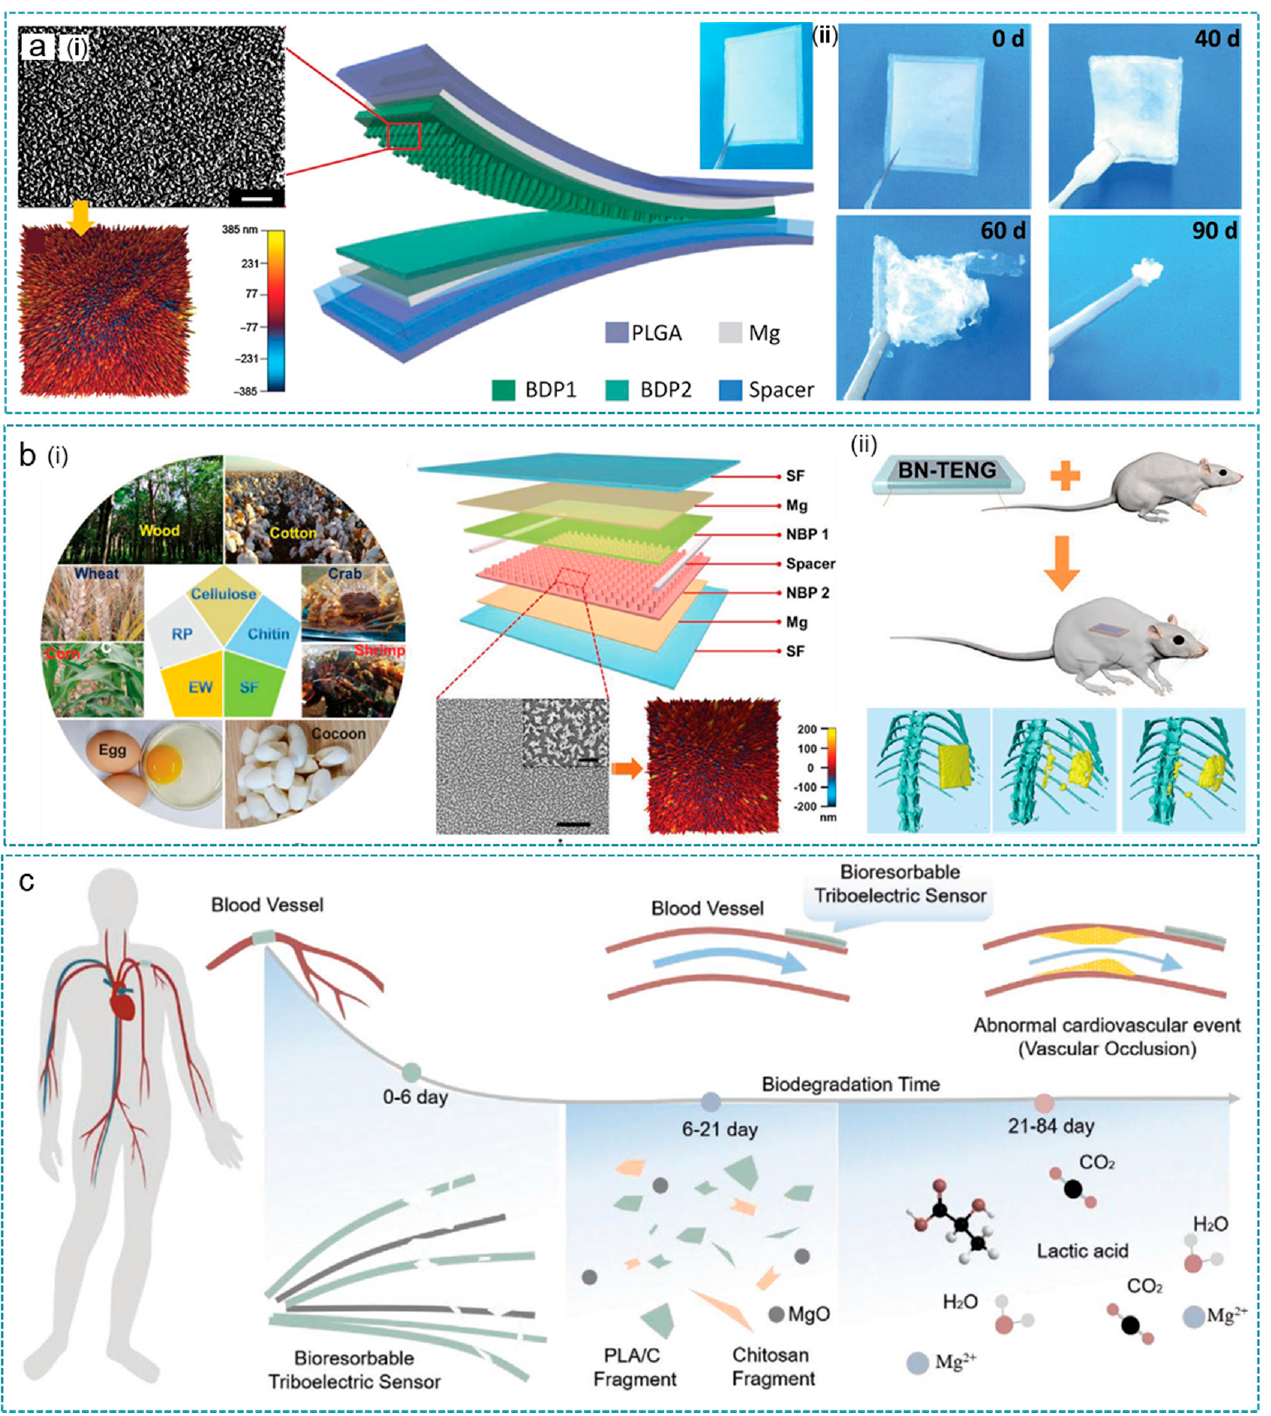
Figure 9. Degradable and absorbable TENGs. ( a ) Biodegradable TENG (BD-TENG) as a lifetime designed implantable power source. The structure diagram (i) and in vitro degradation process (ii) of the BD-TENG. Reprinted from Ref. [180]. Copyright 2016 American Association for the Advancement of Science. ( b ) The structure of fully bioabsorbable natural-materials-based TENGs (i) and the in vivo biodegradation process (ii). Reprinted with permission from Ref. [189]. Copyright 2020 American Chemical Society. ( c ) A bioresorbable dynamic pressure sensor based on TENG. Reprinted with permission from Ref. [93]. Copyright 2021 John Wiley & Sons.